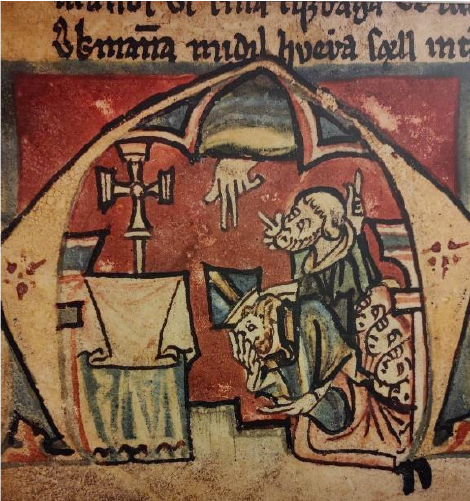
Figure 8. An illustration in the manuscript Skarðsbók , showing the Hand of God, a bishop, a priest, and commoners (© Steinunn